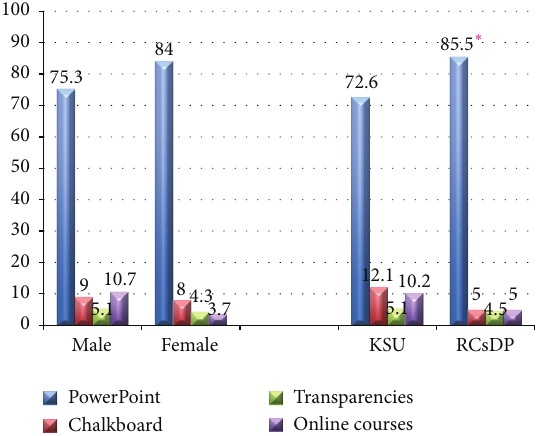
Figure 3: Percentage of dental students’ preferences regarding lecturing method ( ∗ 𝑃 < 0.05 ).